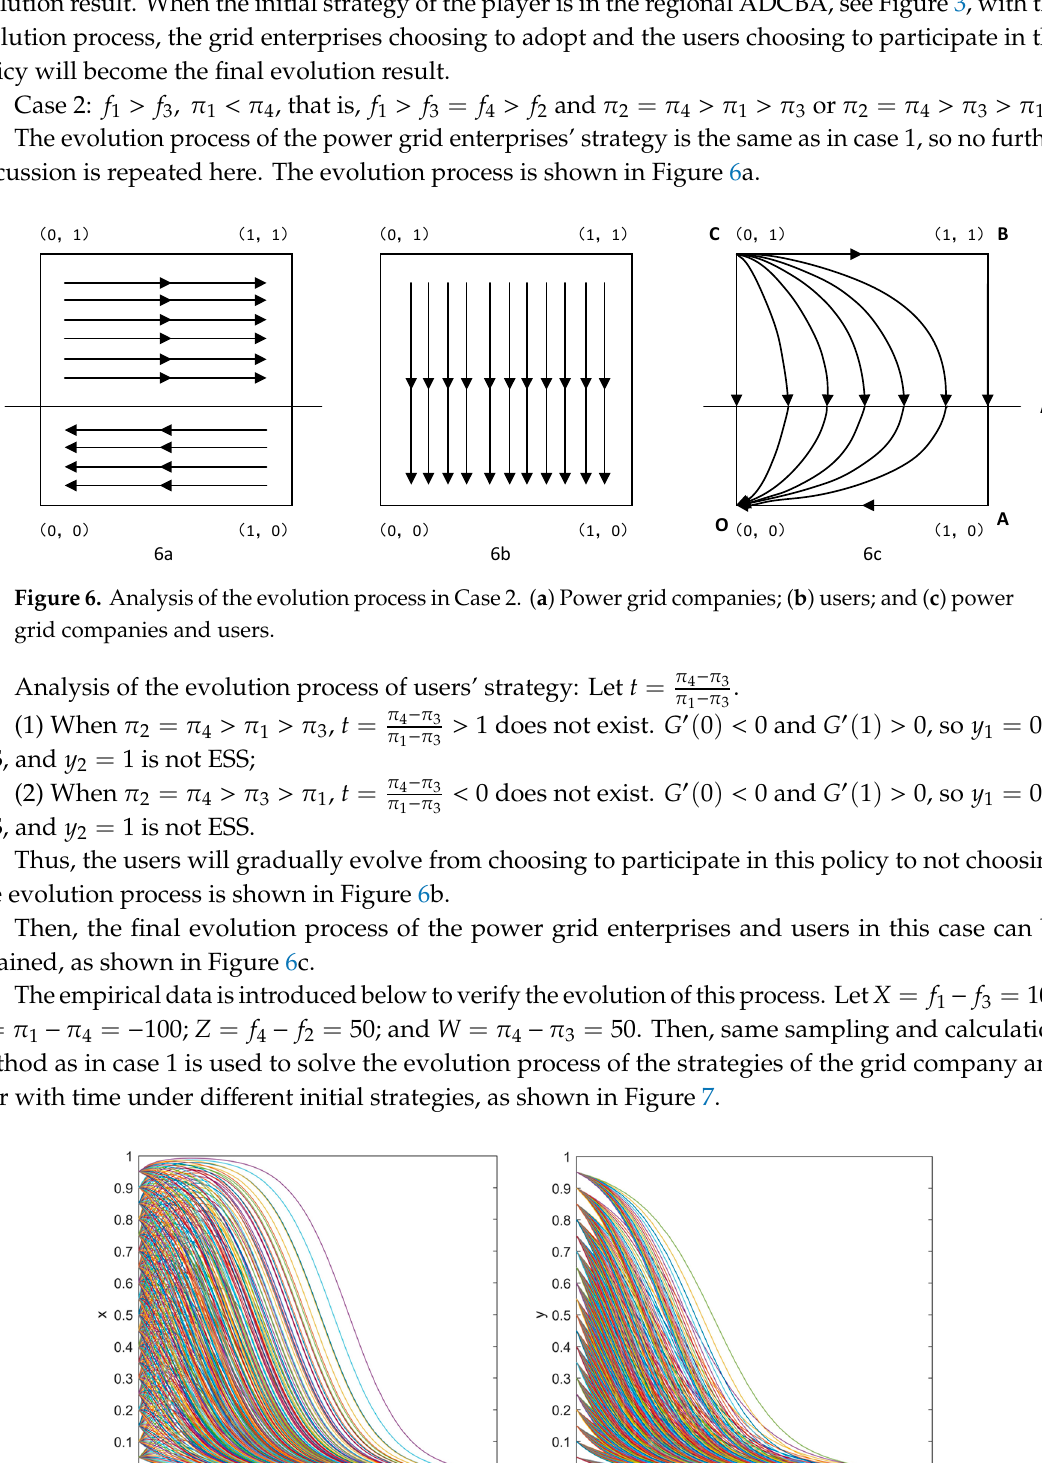
16 of 23 Figure 5. Evolution of the integrated strategy in Case 1. Case 2: